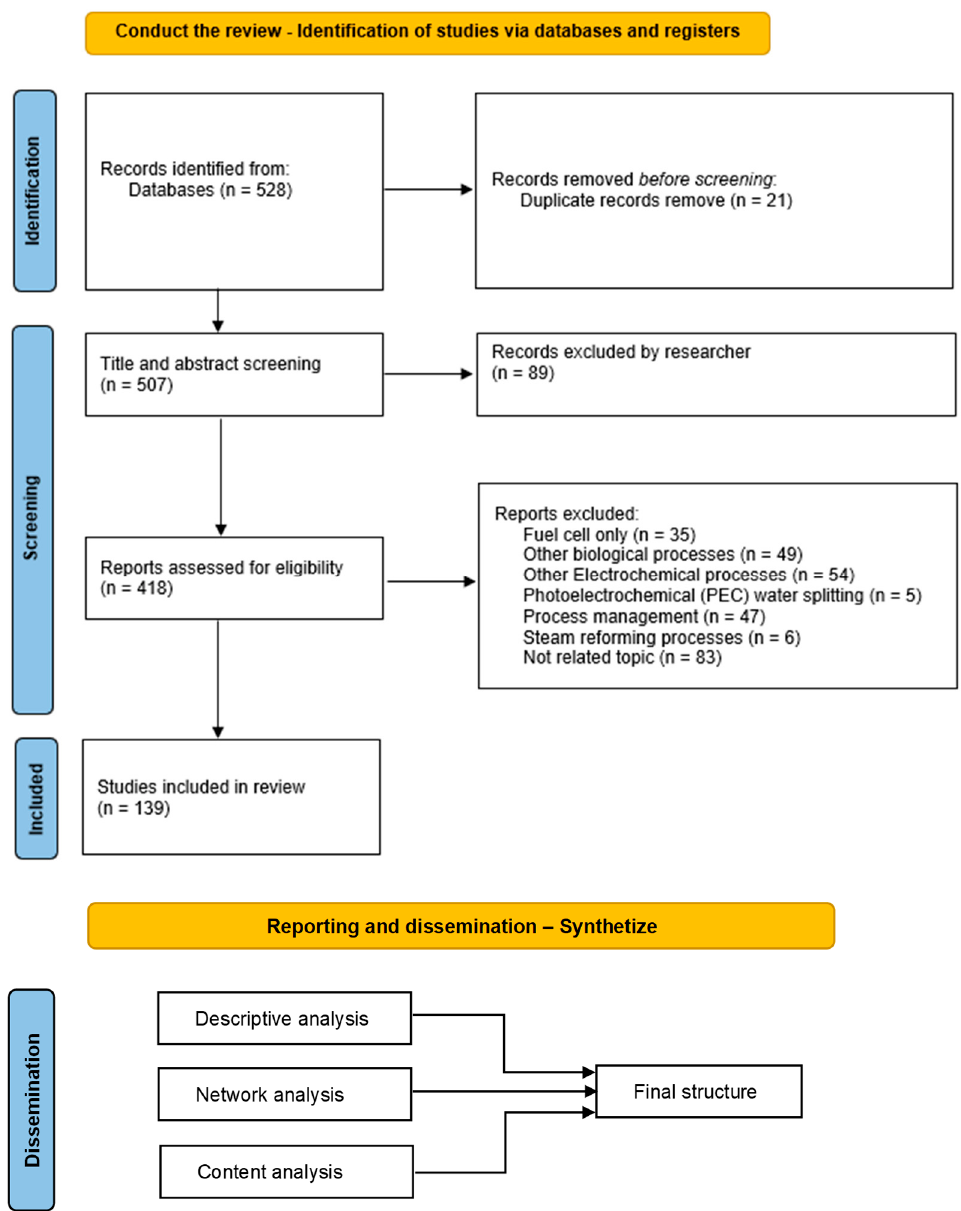
Figure 3. Flow chart of the systematic review procedure applied [5,8].